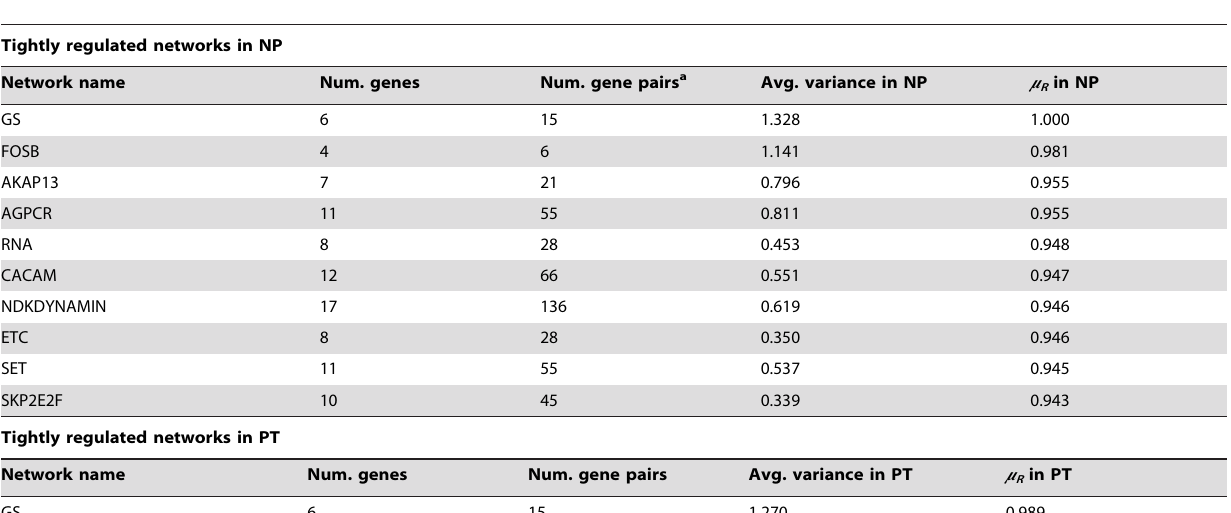
Table 1. Most tightly regulated networks in normal prostate and primary and metastatic prostate tumors, as indicated by rank conservation index